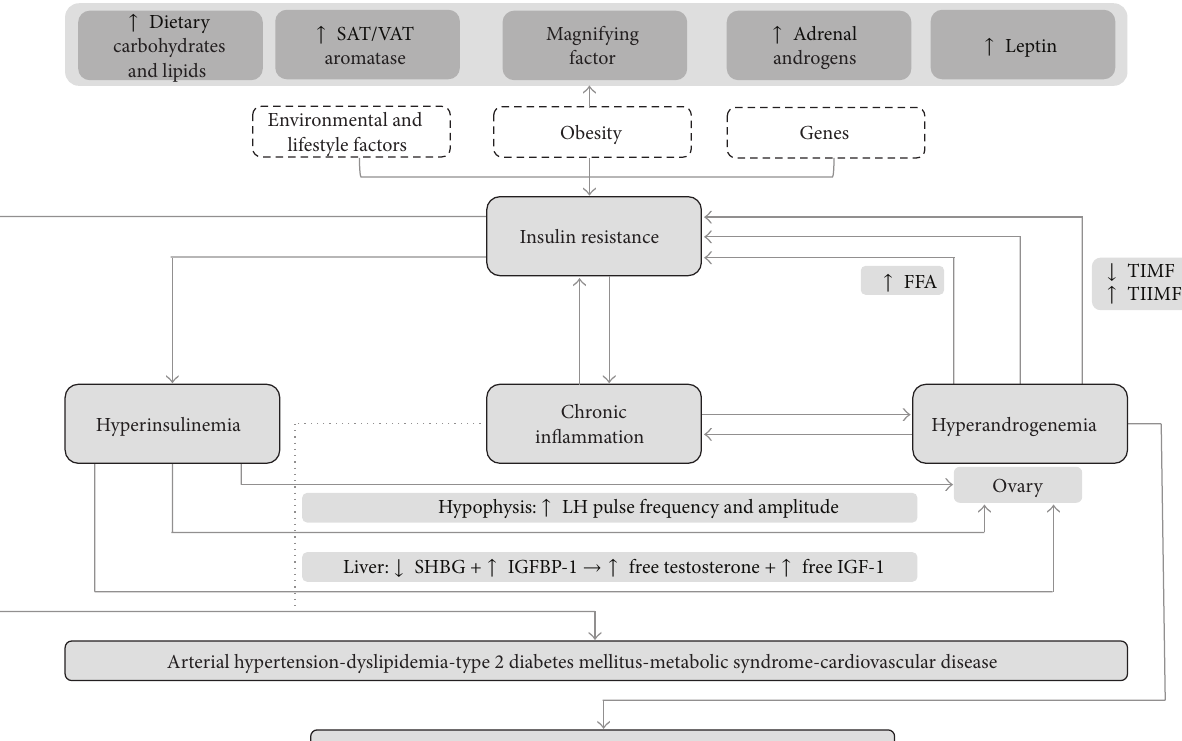
Figure 1: Interactions among insulin resistance, hyperinsulinemia, and hyperandrogenemia in the etiopathogenesis and progression of polycystic ovary syndrome and related comorbidities. SAT = subcutaneous adipose tissue; VAT = visceral adipose tissue LH = luteinizing hormone; SHBG = sex hormone binding globulin; IGFBP-1 = insulin-like growth factor binding protein-1; IGF-1 = insulin-like growth factor- 1; FFA = free fatty acids; TIMF = type I muscle fibers; TIIMF = type II muscle fibers. Although details of the exact etiopathogenesis of